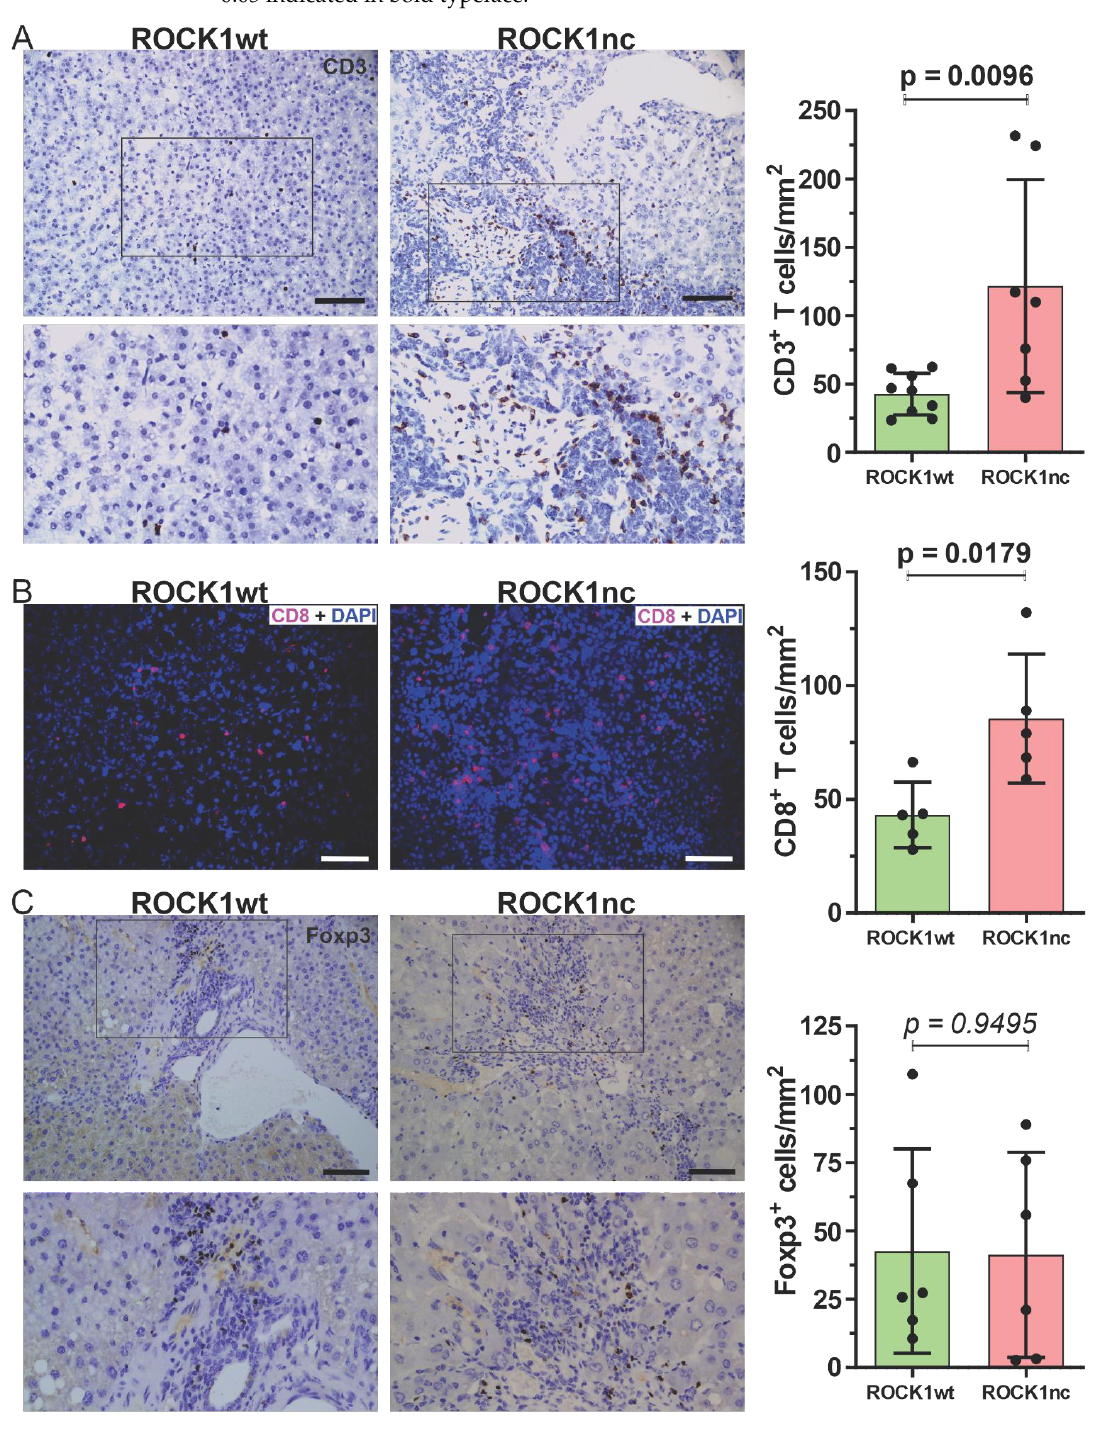
Figure 4. ROCK1nc liver tumours show greater CD3+ and CD8+ T cell numbers than ROCK1wt liver tumours. ( A ) Representative IHC images of anti-CD3 antibody-stained liver sections